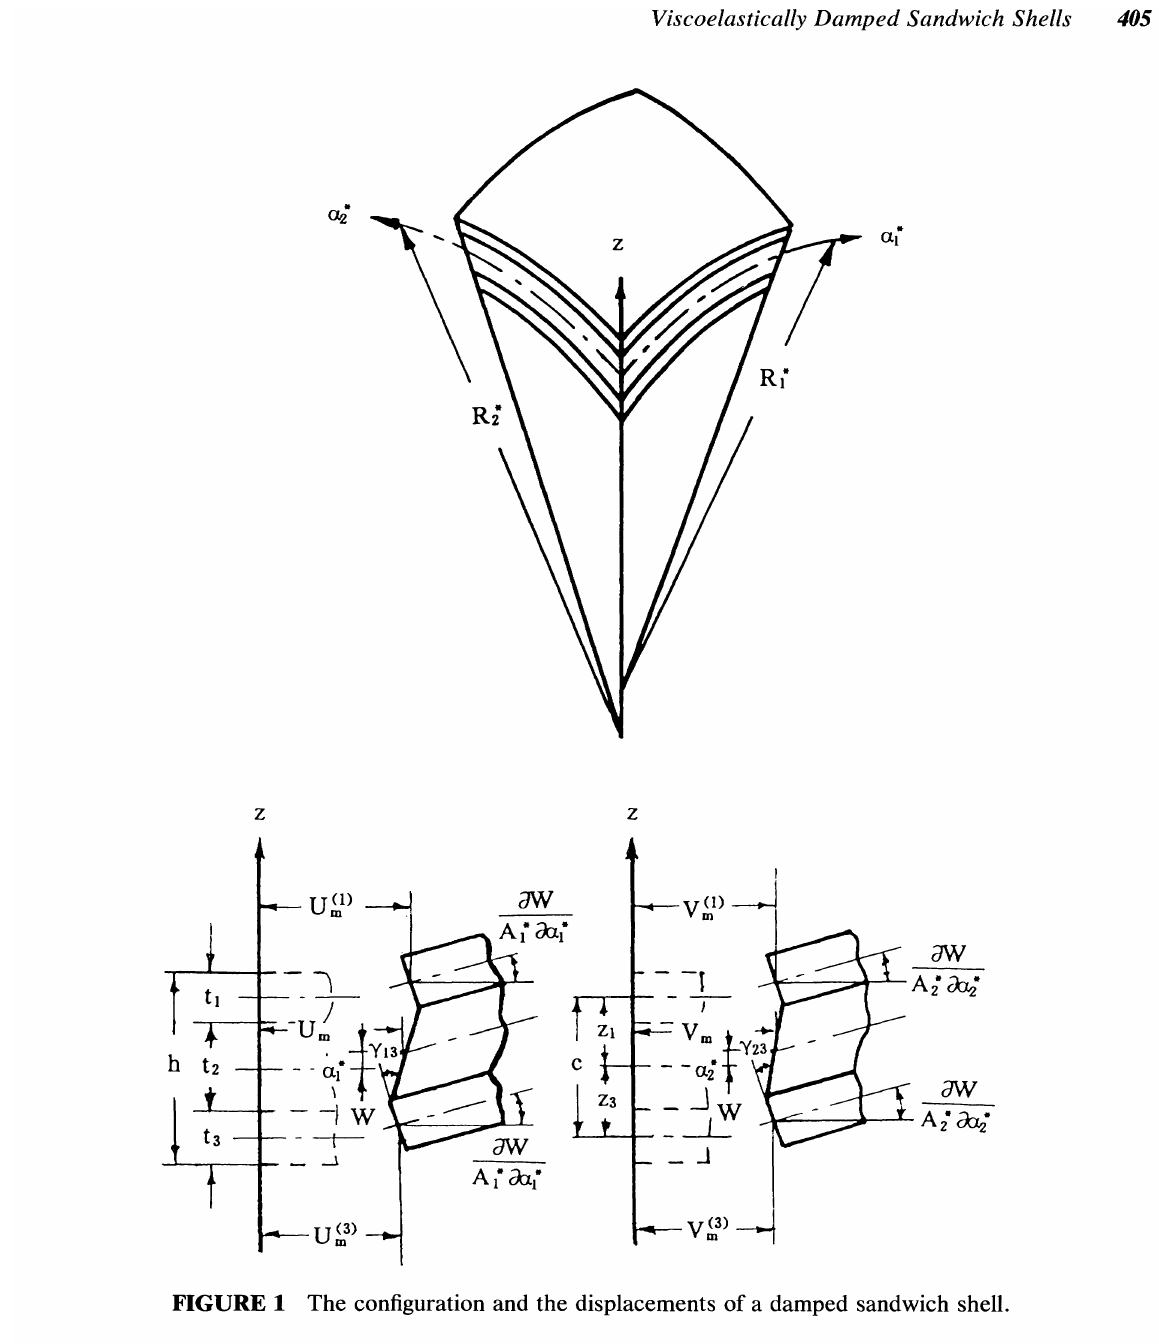
FIGURE 1 The configuration and the displacements of a damped sandwich